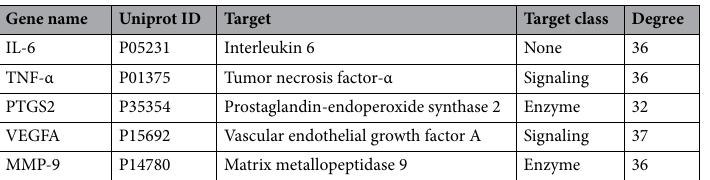
Table 2. Hub genes of CXL for treating inflammation and degree